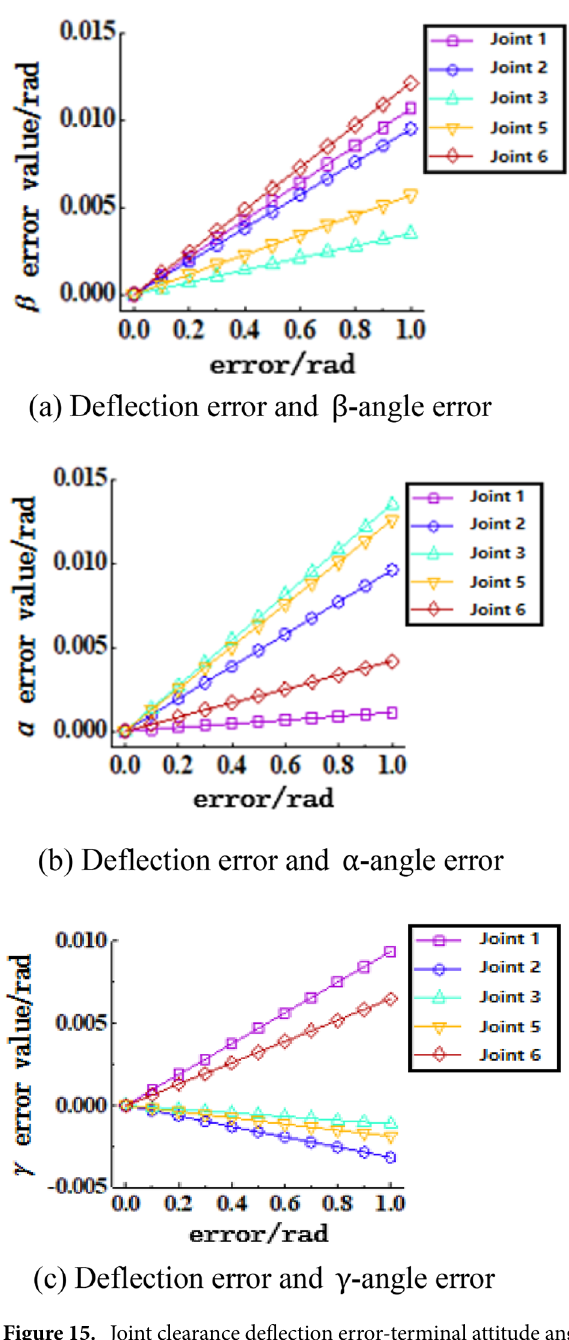
Figure 15. Joint clearance deflection error-terminal attitude angle sensitivity curve, ( a ) Deflection error and β -angle error, ( b ) Deflection error and α -angle error, ( c ) Deflection error and γ -angle